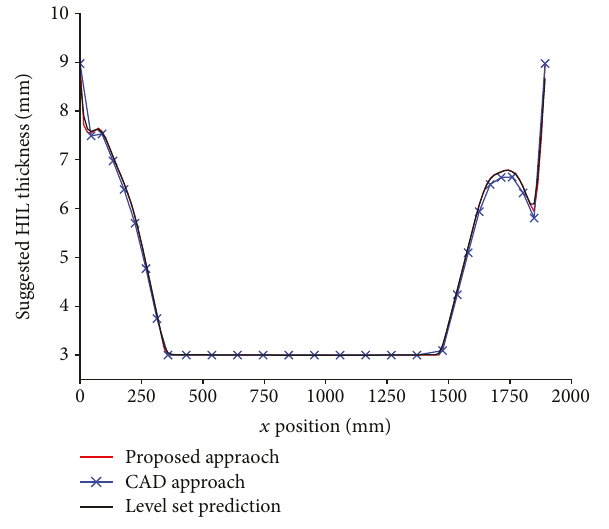
Figure 9: Resulting L values on sampling sections.